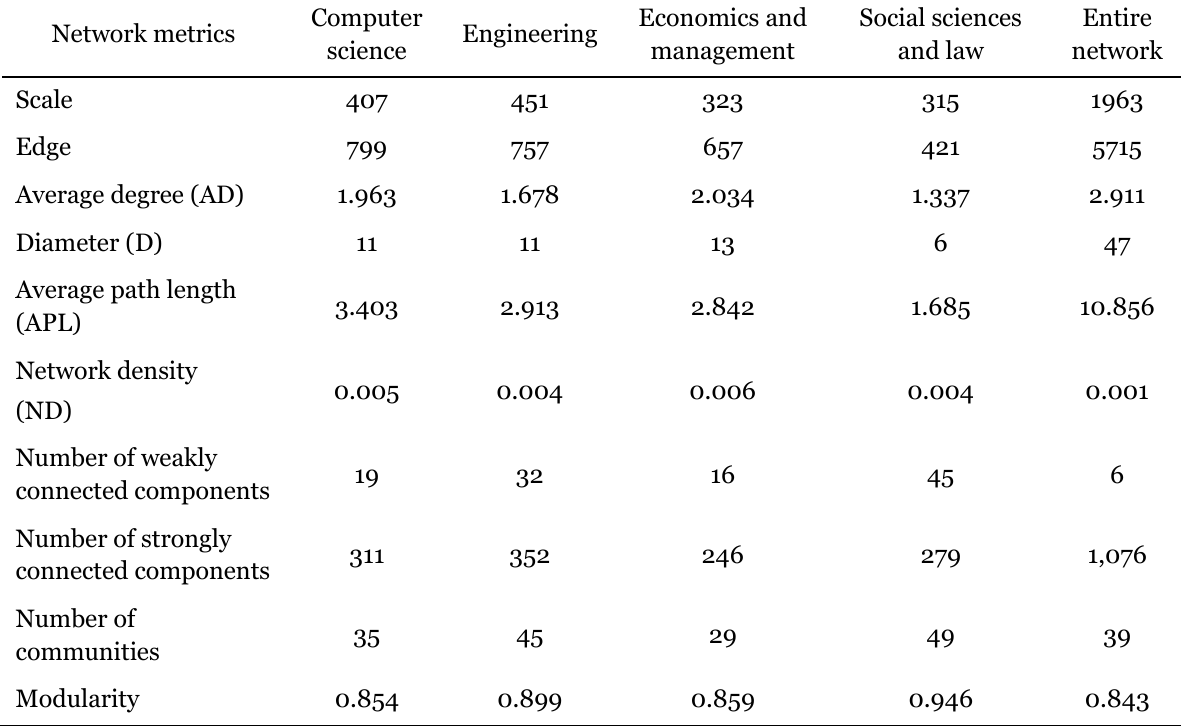
Summary of Statistical Properties of Four Disciplinary